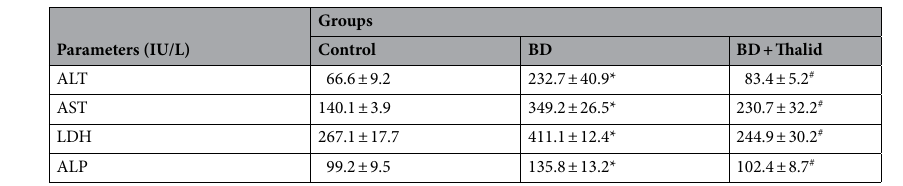
Table 2. The serum levels of ALT, AST, LDH, and ALP. The samples were analysed by clinical chemistry testing. Data are expressed as the means ± SEM. * p < 0.05 versus Control group. # p < 0.05 versus BD group.